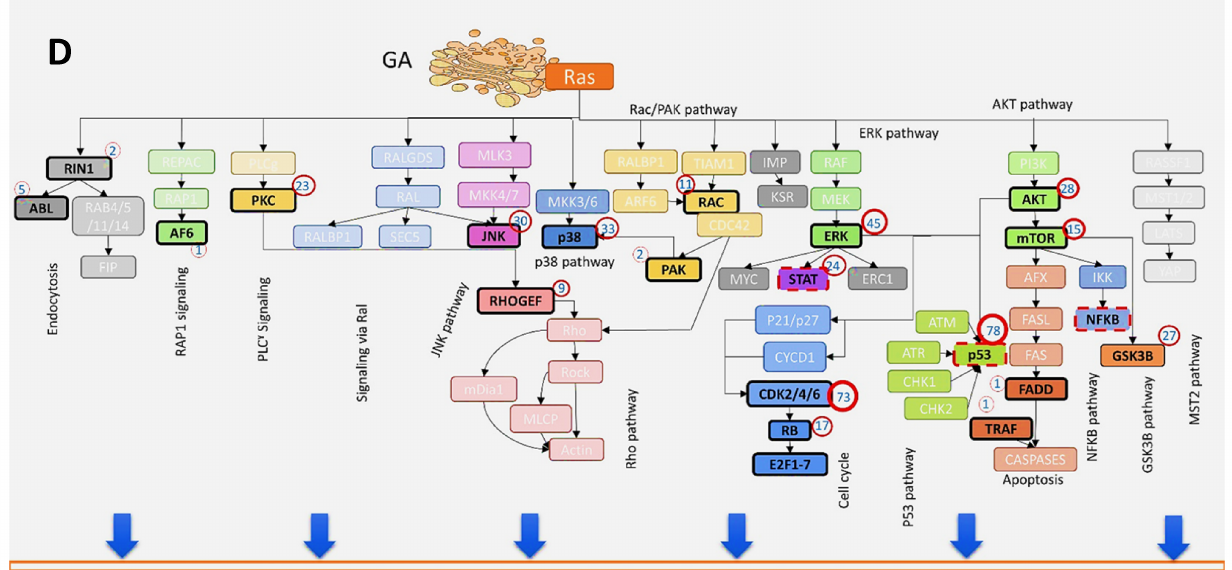
Figure 6. Signaling capacities of known RAS effector pathway components at different HRAS localizations superimposed on diagrams of these pathways. Signaling pathways activated when HRASV12 is located at the ( A ) disordered membrane (DM); ( B ) lipid rafts (LR); ( C ) endoplasmic reticulum (ER); and ( D ) Golgi apparatus (GA). The nodes displayed in bright colors are present in the corresponding network. The red circle adjacent to each node shows the number of interactions it participates in. In cases where a node represents more than one protein (isoforms or homologs), the signaling capacity of the node is represented by the total number of interactions involving all proteins corresponding to the node. The enriched GO terms of the HRAS localization specific transcriptome are shown at bottom of each pathway diagram. This figure is from the supplementary data of